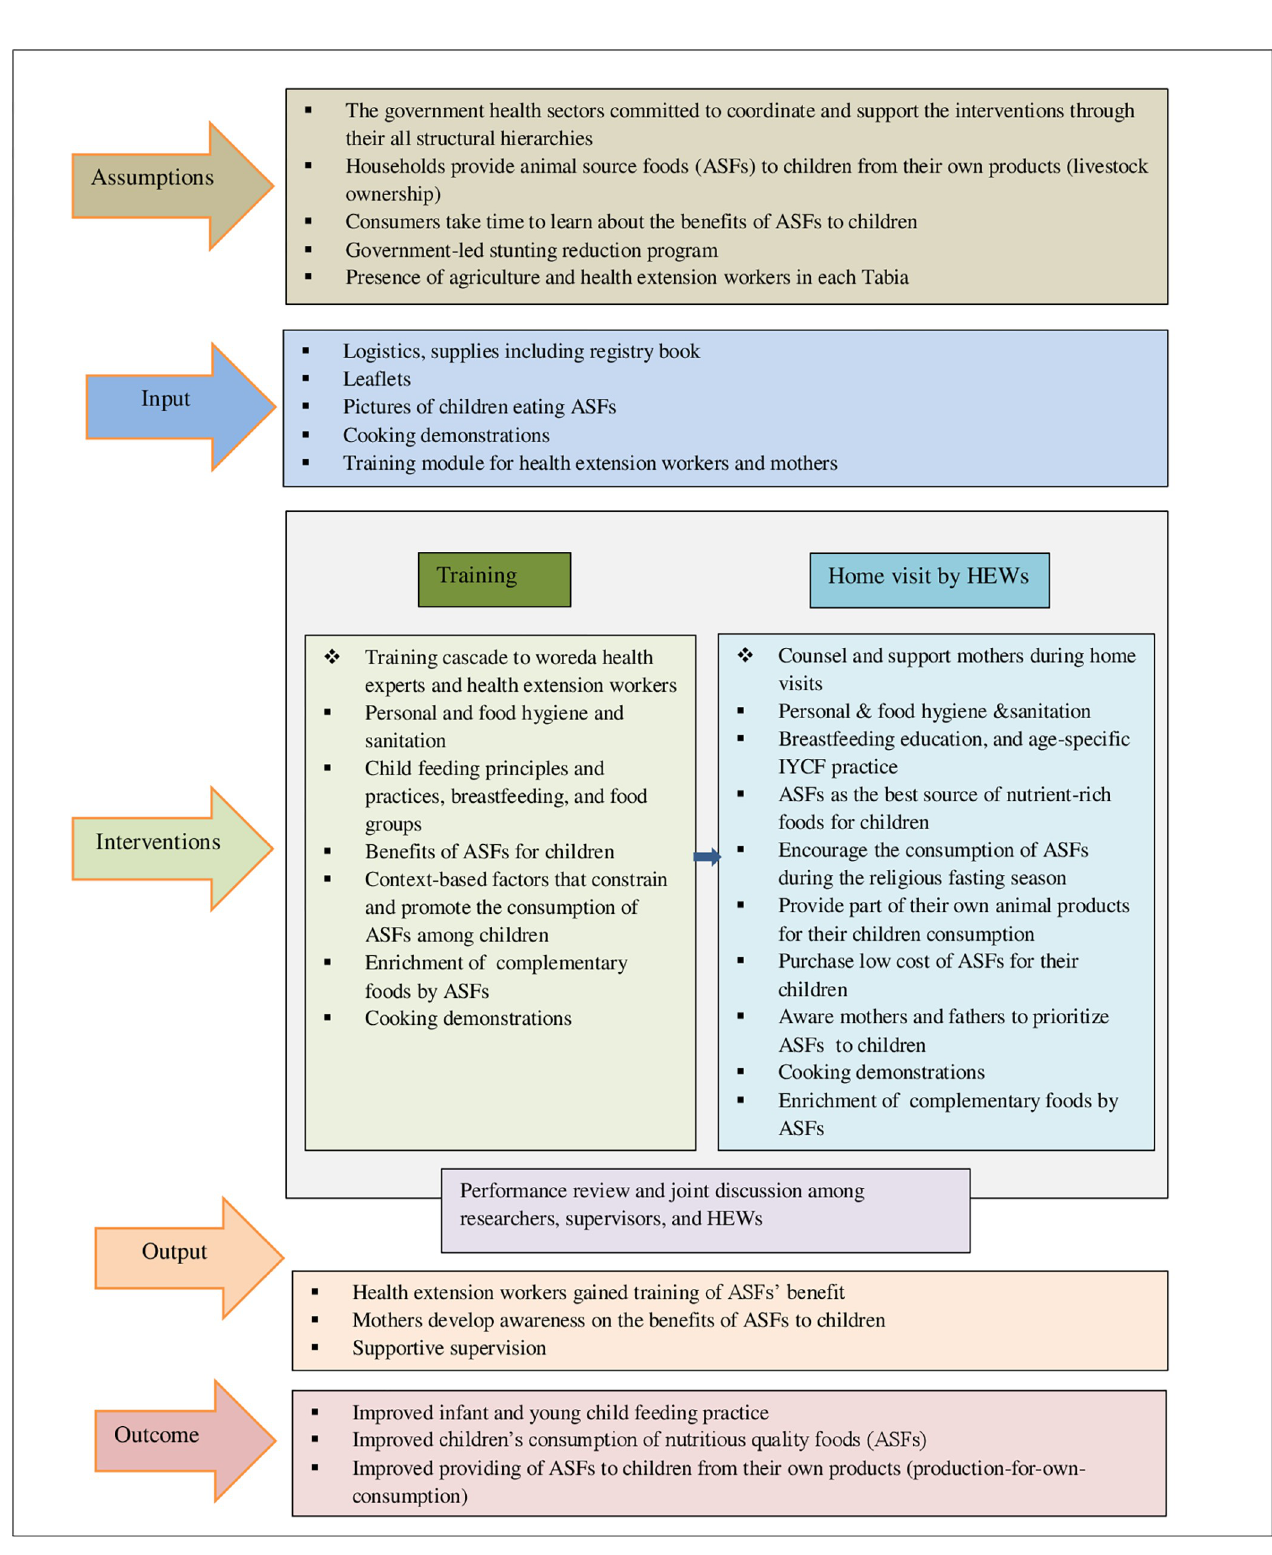
PLOS ONE | https://doi.org/10.1371/journal.pone.0277240 November4,